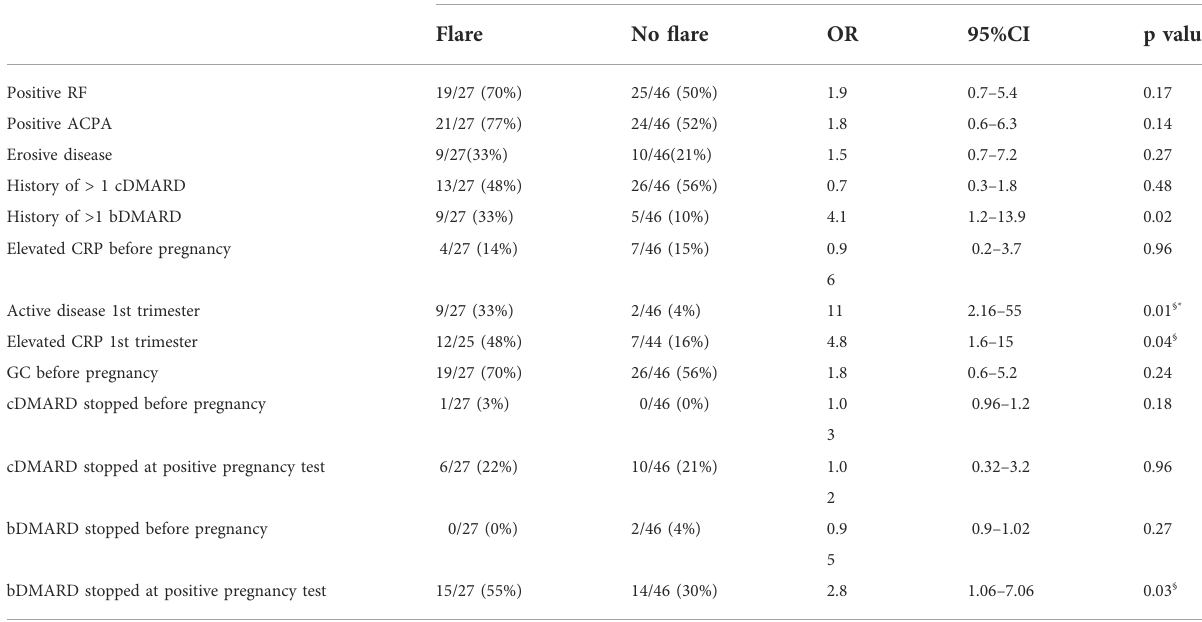
TABLE 3 Risk factors for disease fl are during